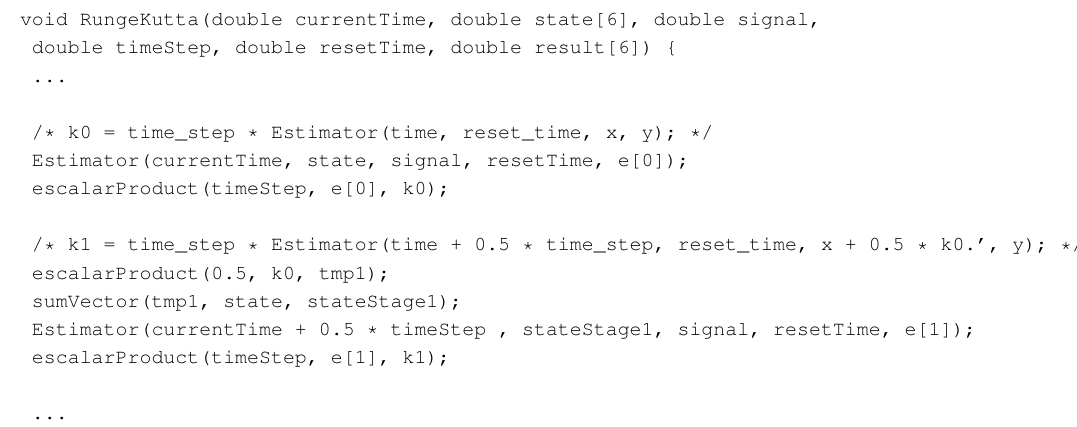
Figure 5. Runge Kutta method C code.